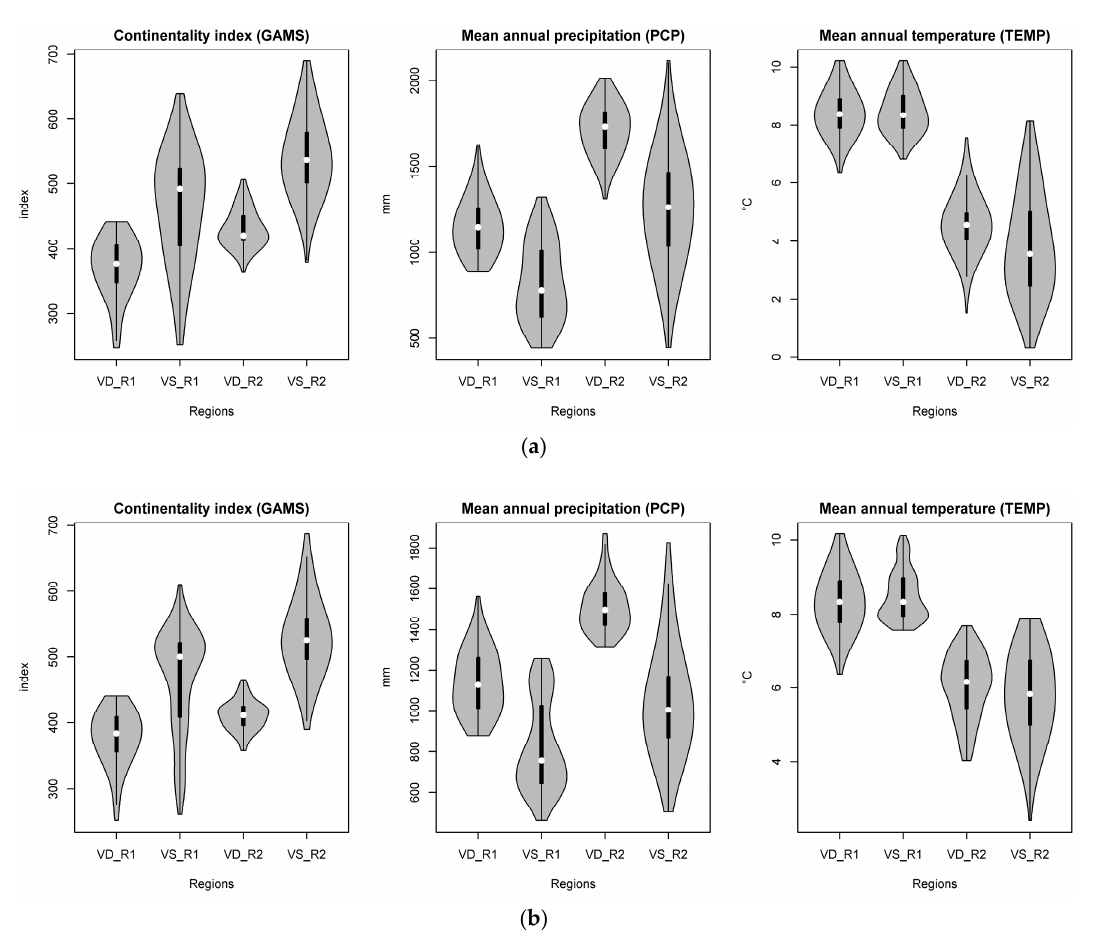
Figure 3. Violin plots for the driving forces distribution in each region. The median is shown as a white circle, the wide black bars represent the interquartile range, the range of values is represented by the thin vertical line, and the shaded areas represent the frequency distribution in each region. ( a ) transition from open forest (1997) to closed forest (2009); ( b ) transition from intensive agriculture (1997) to open forest (2009).